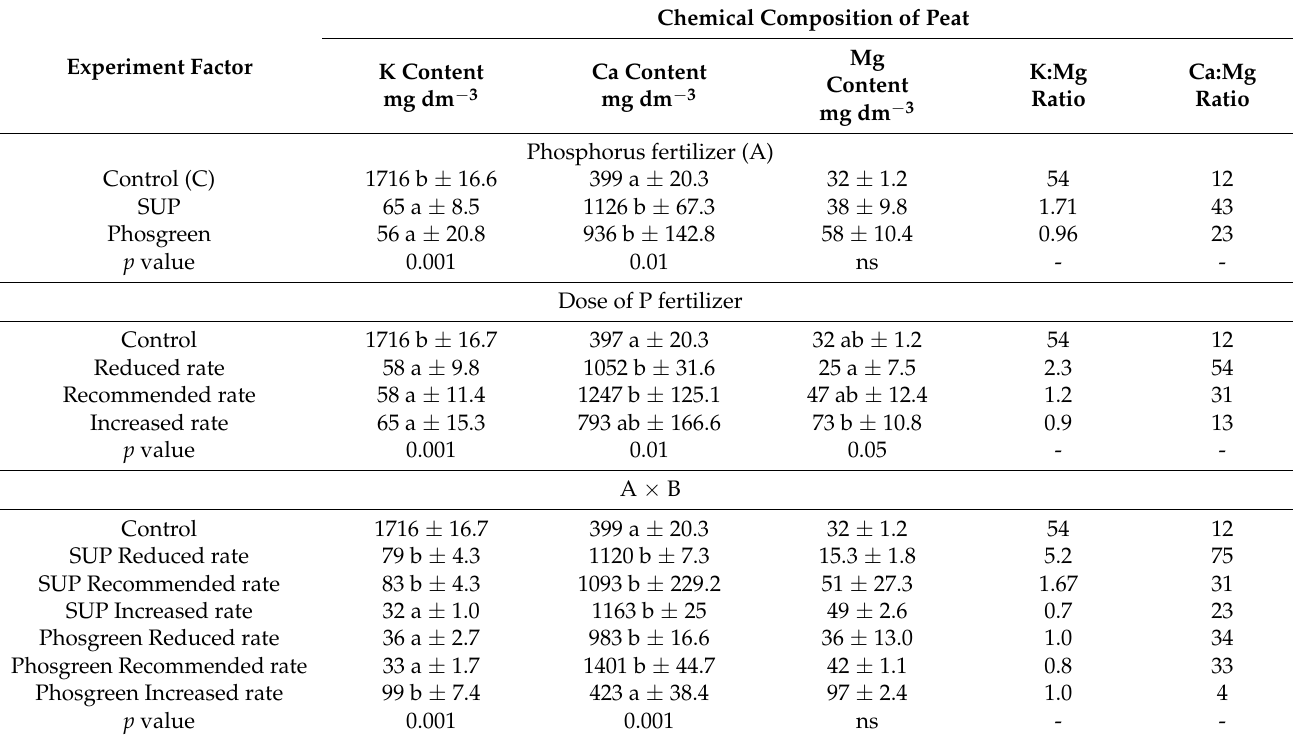
Table 3. The effect of SUP and Phosgreem fertilization on the K and Ca content in peat.